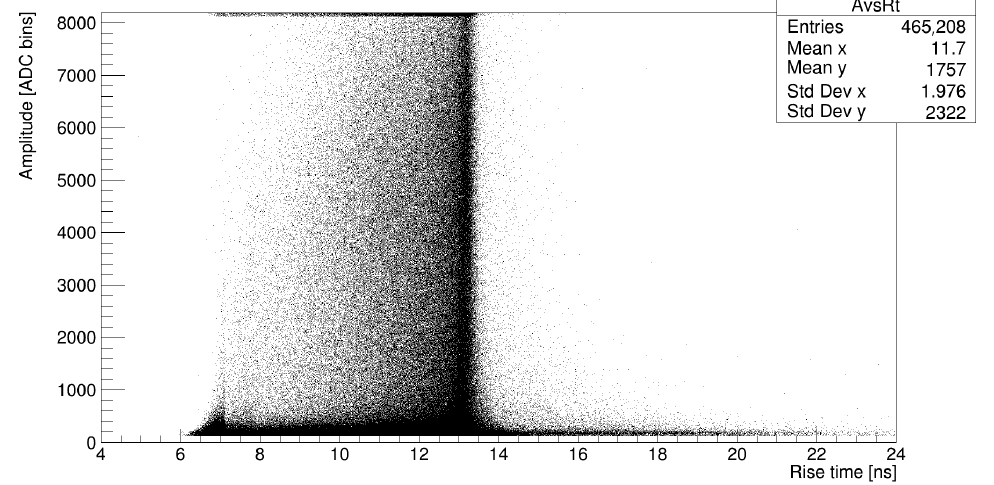
Figure 2. Amplitude vs. rise time of typical pulses captured with a